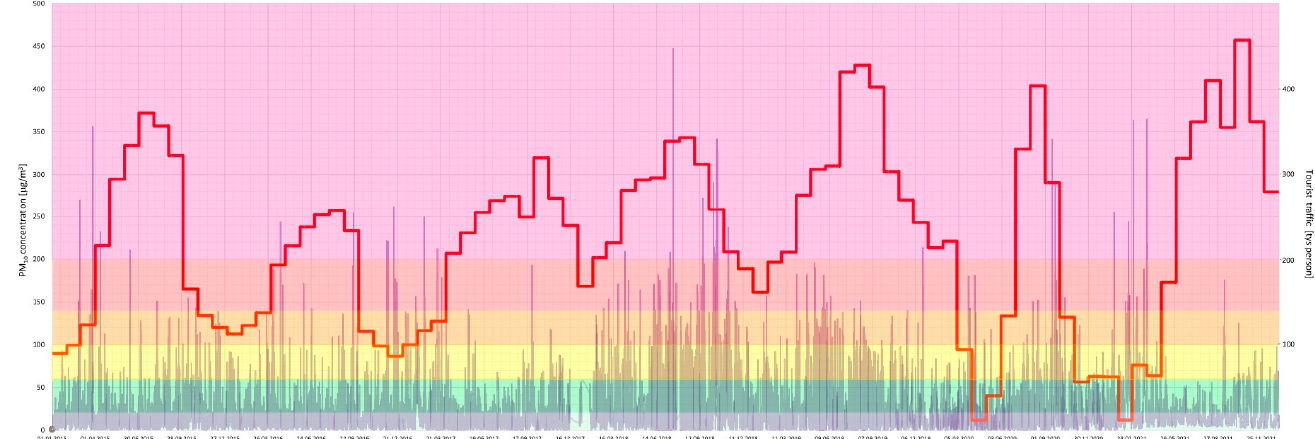
Figure 6. PM 10 concentration in relation to tourist traffic (the Gda ń sk agglomeration, years 2015–2021). Source: own study.